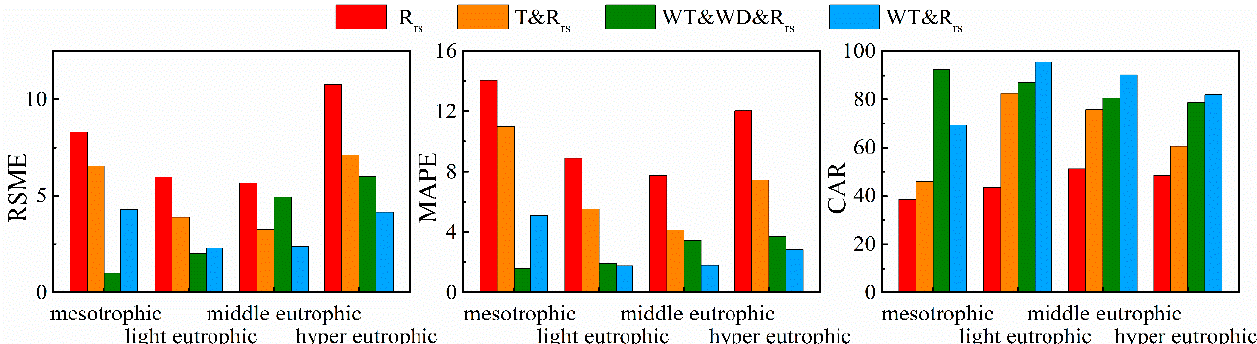
Figure 8. Accuracy of the BP-NN-based TSI estimation algorithm for each trophic state.